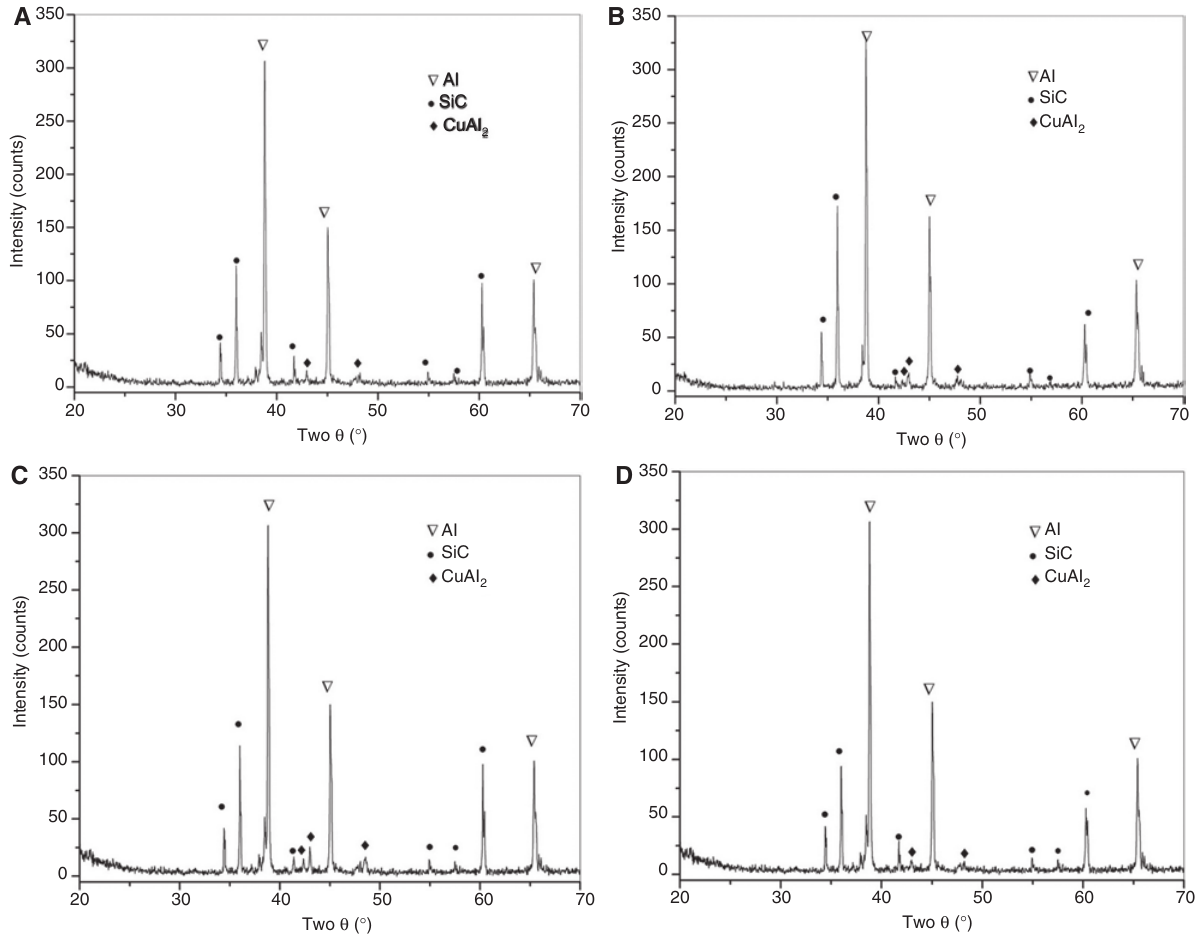
Figure 3 XRD spectra of the composites fabricated at hot pressing temperatures of (A) 540 ° C, (B) 560 ° C, (C) 580 ° C, and (D) 600 °